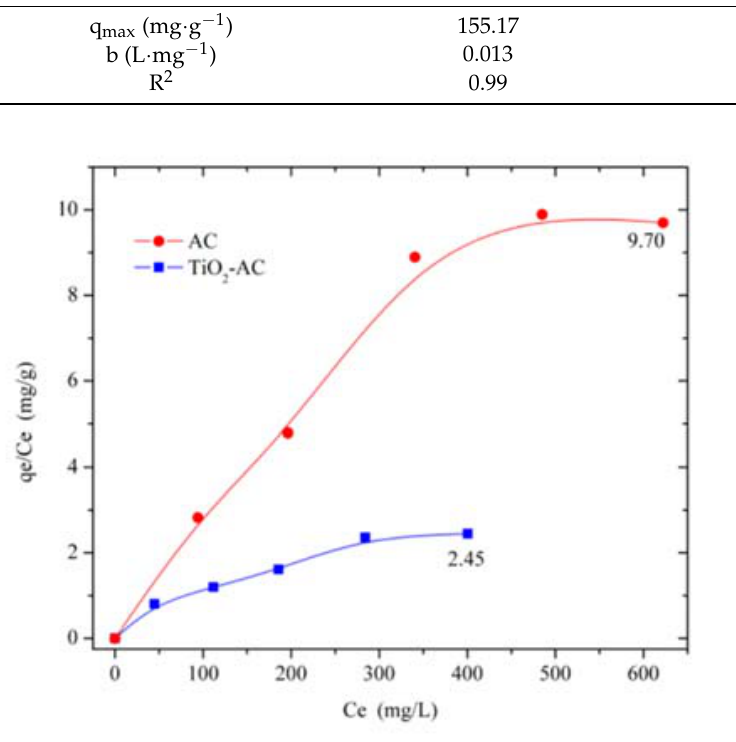
Figure 1. Langmuir adsorption isotherms of cyanide (T = 20 ◦ C; 1 g TiO 2 -AC/L). Individually, the adsorption of cyanide ion tests were performed for three concen- trations 30 g/L, 45 g/L, and 60 g/L of TiO 2 -AC in 500 mg/L synthetic NaCN solutions, under dark conditions in the continuous flow reactor during 24 h at a pH of 10.5 and 20 ◦ C. Another assay was carried out with 60 g/L of AC at the same conditions. The results listed in Table 4 demonstrate that AC (60 g/L) reached 78% of cyanide degradation due to the adsorption process. It is assumed that adsorption and oxidation processes simultaneously occurred due to oxidant species formed during the process with the dissolved oxygen and functional groups of the AC